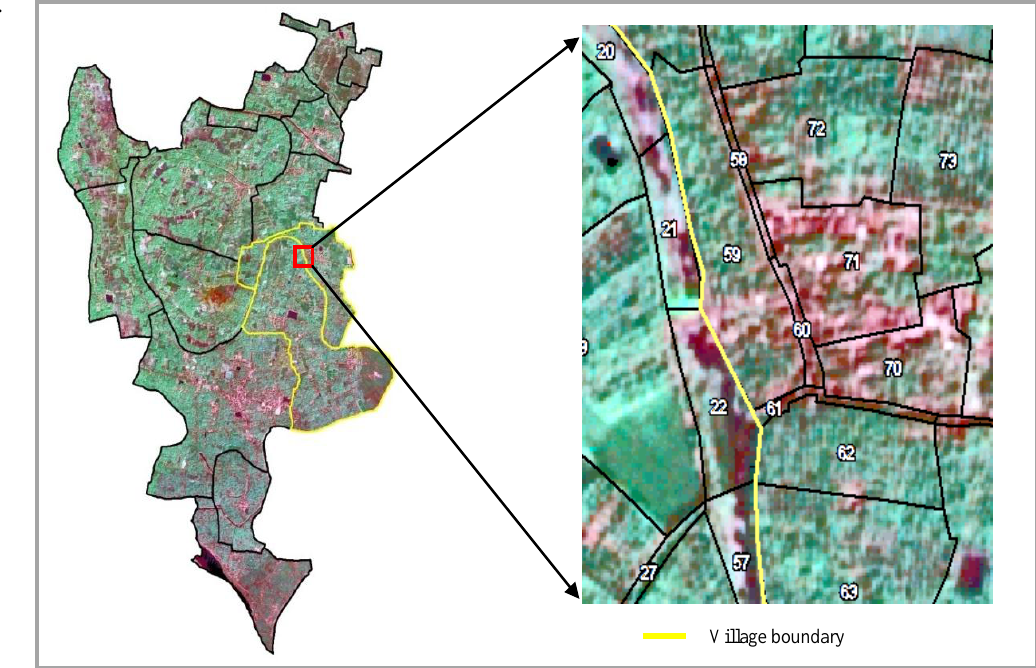
Figure 12: Village boundary (derived from cadastral map) overlaid on